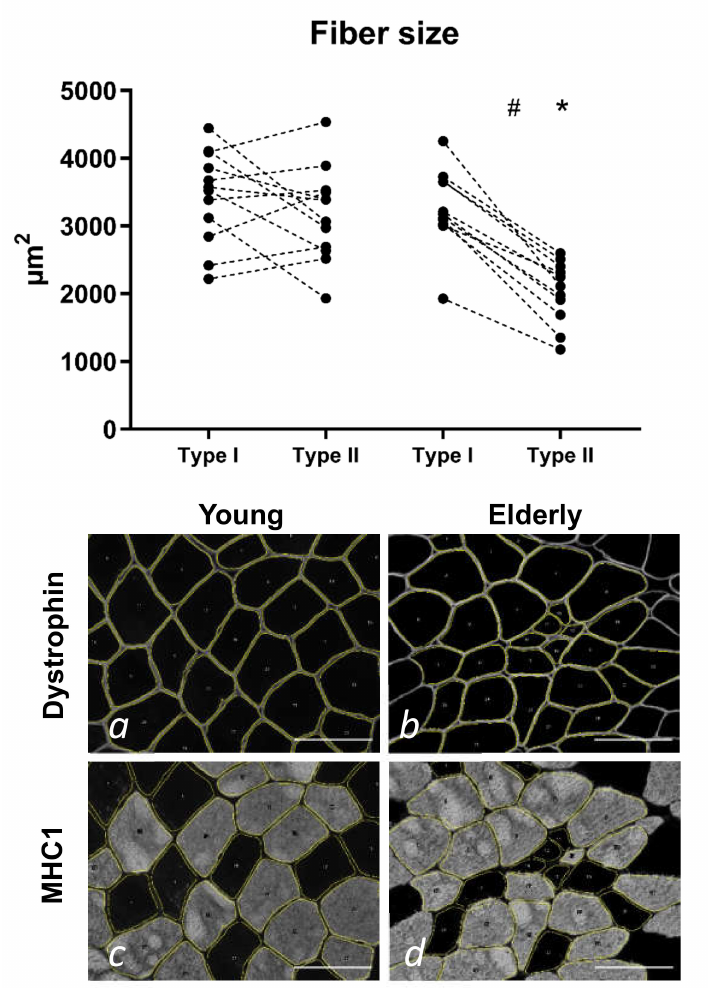
Figure 1. Muscle fibre size analysis in biopsy cross-sections from the control legs of 12 young and 11 elderly women. Individual values are displayed and with type I and II values for an individual connected by a dashed line. The type II fibres of the elderly individuals were significantly smaller than their own type I fibres and the type II fibres of the younger individuals. * p < 0.001 vs. young type II, # p < 0.001 between fibre types in elderly. Images ( a – d ) illustrate the analysis process. (b,d) show representative images of the same area, which has been delineated by the macro in ImageJ. This is an elderly subject with a mean fibre size of 3025 µ m 2 and 1688 µ m 2 for type I and II fibres, respectively. Similarly, a and c show representative images of the same area in a young subject with a mean fibre size of 3574 µ m 2 and 3378 µ m 2 for type I and II fibres, respectively. MHC1, myosin heavy chain 1. Scale bars = 100 µ